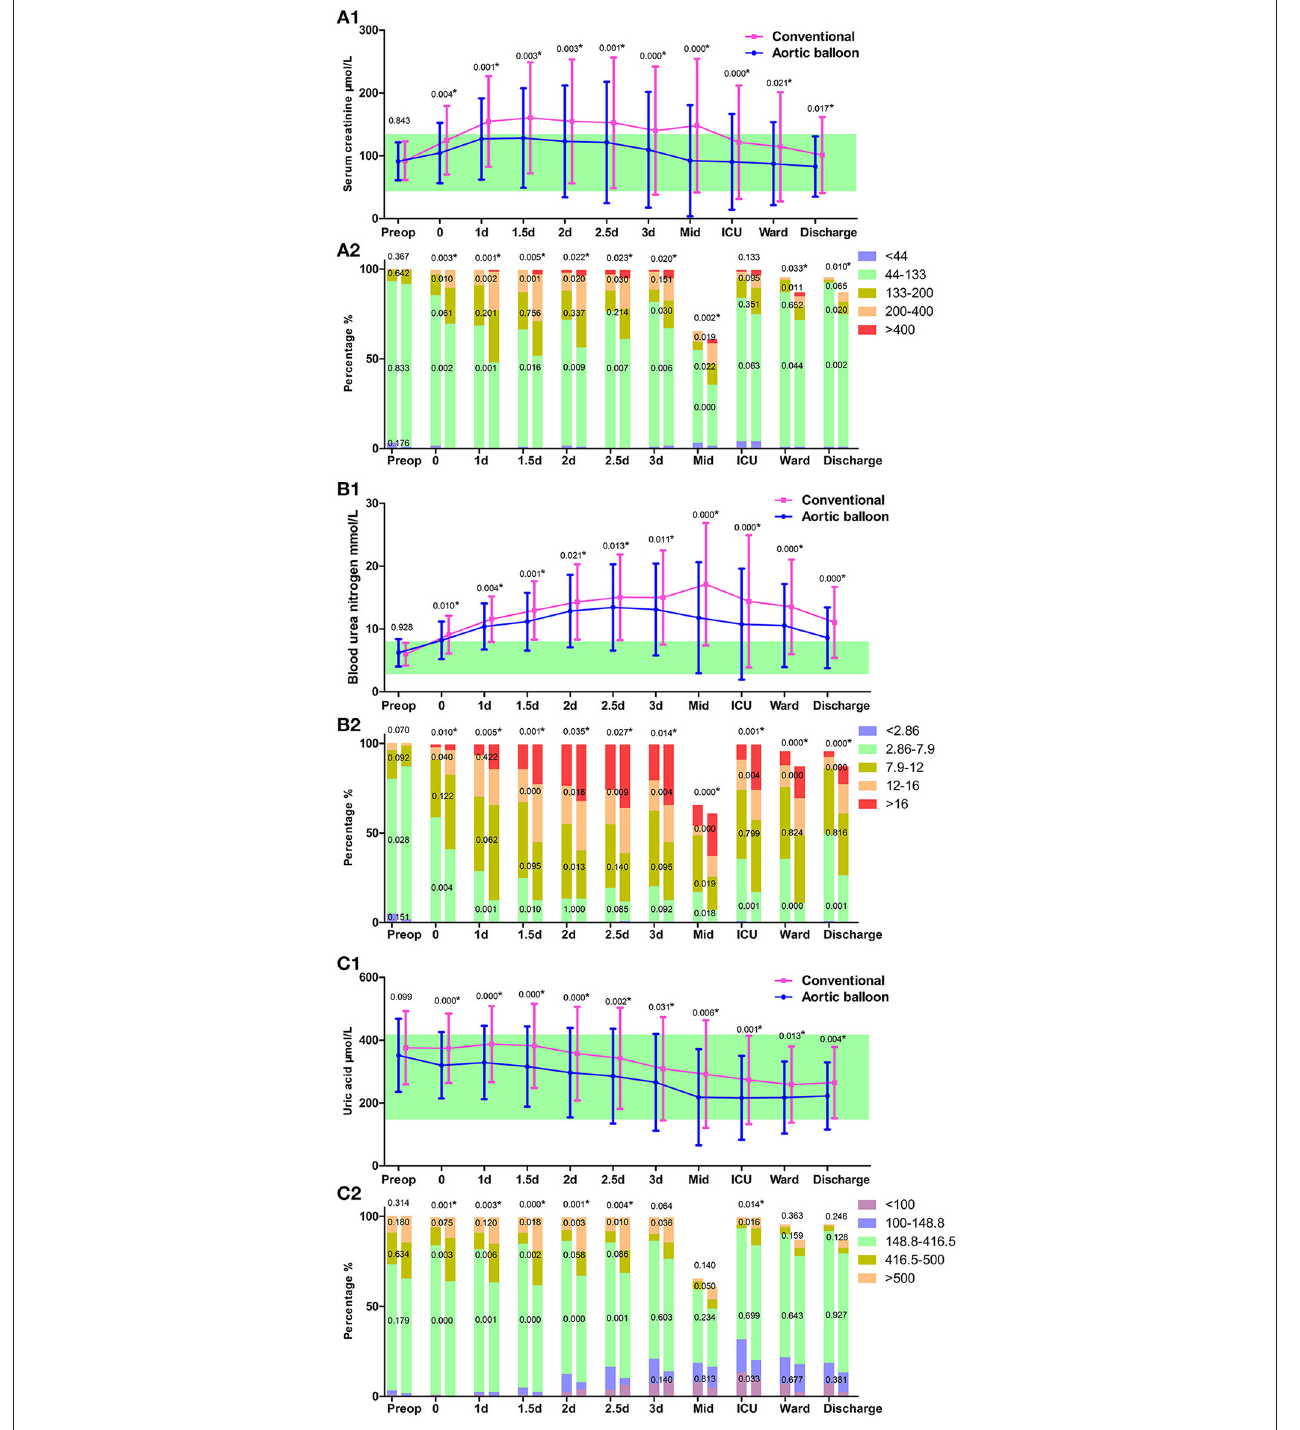
FIGURE 2 | Renal function. (A1) The trajectory of serum creatinine (Scr). (A2) Scr grading in the column. (B1) The trajectory of blood urea nitrogen (BUN). (B2) BUN grading in the column. (C1) The trajectory of uric acid (UA). (C2) UA grading in the column. Data points are represented by mean with standard deviation bars. The green band represents the referred normal range of the examination. The P -value of the continuous variable is represented above the standard deviation bar, which is calculated by Student’s t-test (normally distributed) or Mann-Whitney U test (non-normally distributed) with no multiple comparison correction to the P -value. The P -value of the categorical variable is represented in the graded column to represent for each grade, or above the grade to represent a total, which is calculated by χ 2 test. * P < 0.05.